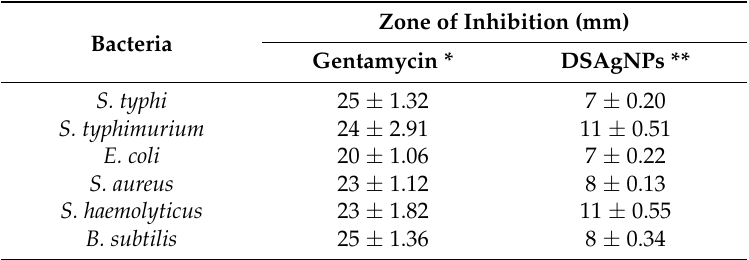
Table 1. Antibacterial activity of